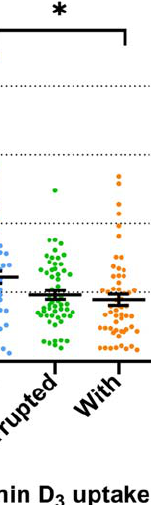
Figure 2. The proportion of V δ 2 T cells among CD3 + T cells according to oral vitamin D 3 supple- mentation. All analyzed time points of all donors in three groups are displayed: group 1 (blue): no oral vitamin D 3 , 14 donors; group 2 (green): interrupted oral vitamin D 3 supplementation, 8 donors; group 3 (orange): continuous vitamin D 3 uptake, 9 donors. Bars represent mean values ± SEM. Statis- tical comparison was made by Kruskal–Wallis test and Dunn’s multiple comparison test. * p =